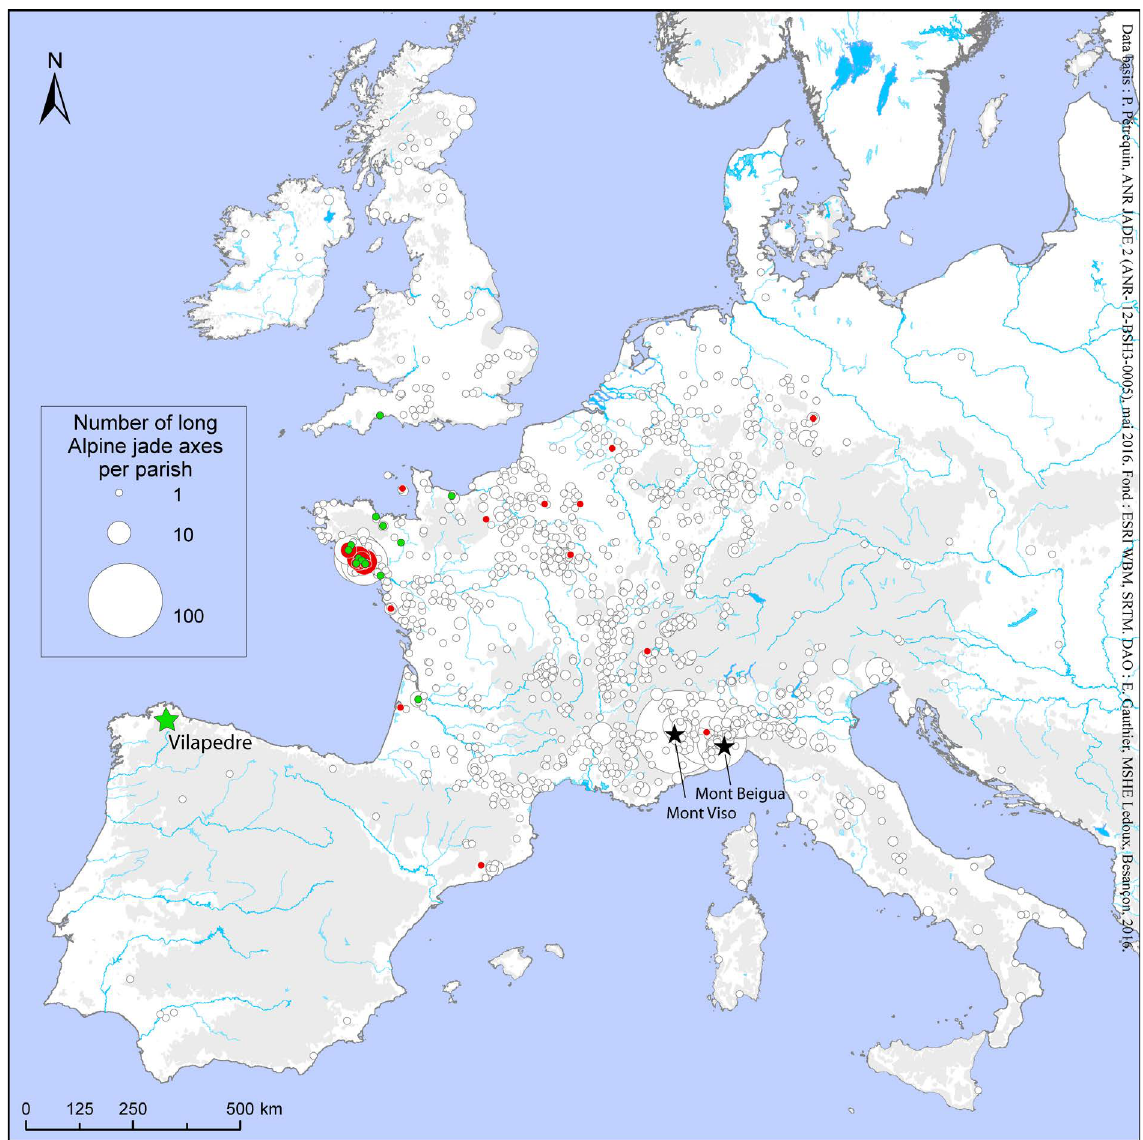
Figure 2. Distribution of long Alpine jade axes in Western Europe (white circles). Green circles: Butt-perforated Tumiac axes, as Vilapedre (green star). Red circles: Tumiac axes. Data base: P. Pétrequin. Mapping: E. Gauthier. NASA - Shuttle Radar Topography Mission (SRTM 3 arc-seconds) version 2.1, USGS., ESRI Basemap Data (licence MSHE C.N.